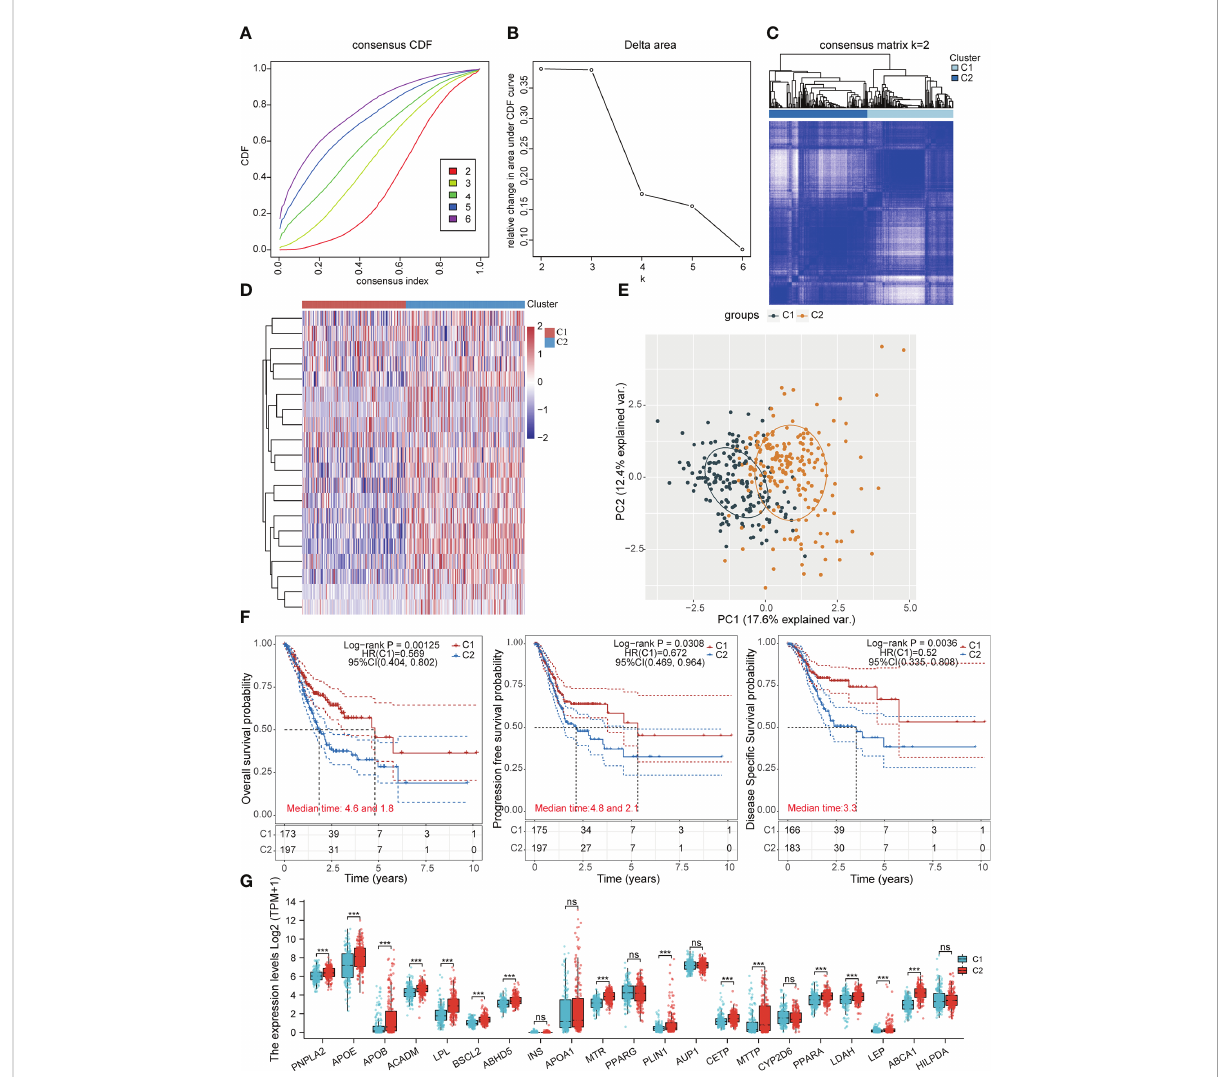
FIGURE 3 Identi fi cation of subtypes associated with LDMRGs in STAD. (A – C) The optimal number of clusters (K=2) was determined for classi fi cation based on the cumulative distribution function (CDF) curve. (D) Heat map of the expression of LDMRGs in different subgroups, red represents high expression and blue represents low expression. (E) Principal component analysis (PCA) of 375 patients with STAD, with each point representing one sample. (F) Survival analysis between different subgroups in the TCGA-STAD cohort, including OS, PFS, and DSS. (G) Differential expression analysis of LDMRGs between different subgroups in the TCGA-STAD cohort. (ns: p > 0.05, *: p ≤ 0.05, **: p ≤ 0.01, ***: p ≤